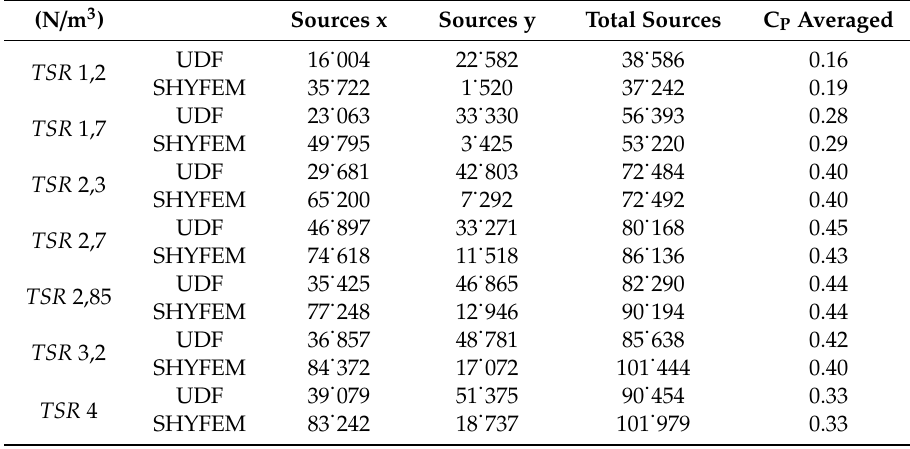
Figure 13. C P comparison between pure CFD, ANSYS, and SHYFEM hybrid models at different TSR values 1.2, 1.7, 2.3, 2.7, 2.85, 3.2, 4 respectively in ( a – g ) and the averaged C P in figure ( h ). Table 3. Source terms entity for both ANSYS and SHYFEM hybrid models.